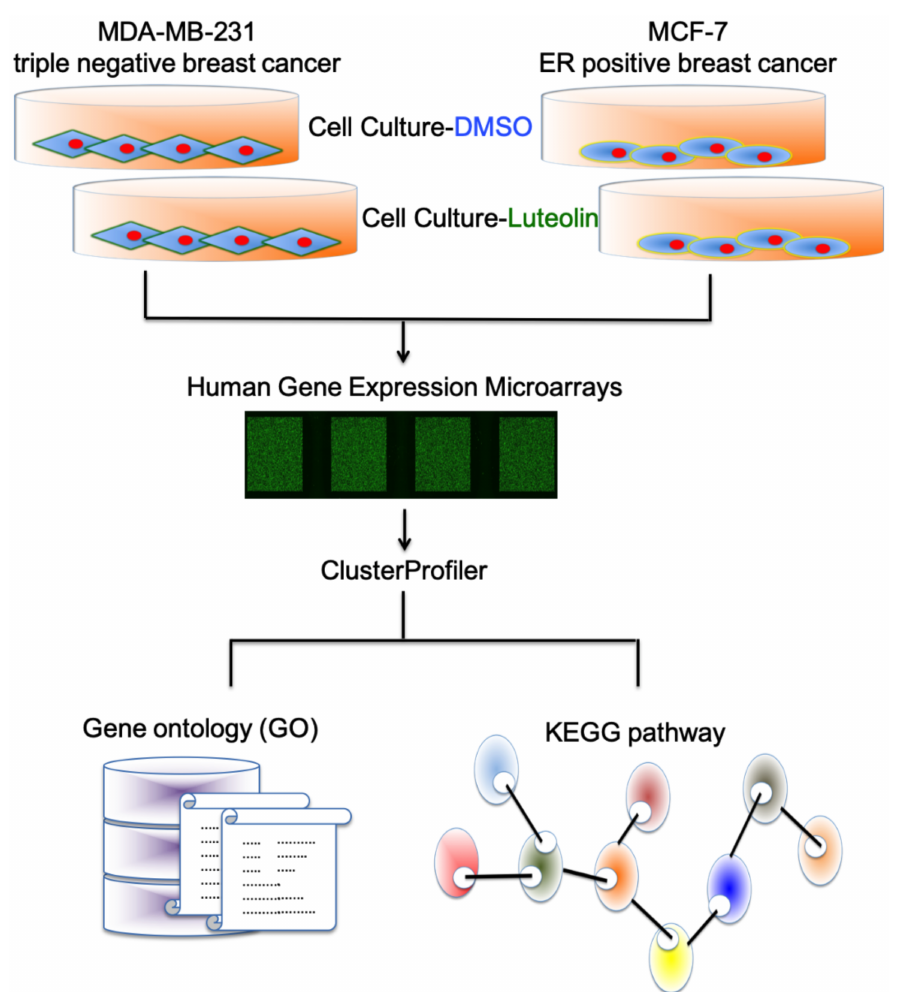
Figure 2. Investigation of luteolin-related changes in MDA-MB-231 and MCF-7 cells. Flowchart illustrating the methods for investigating various gene expression changes in luteolin-treated MDA- MB-231 and MCF-7 cells by gene expression array and bioinformatic